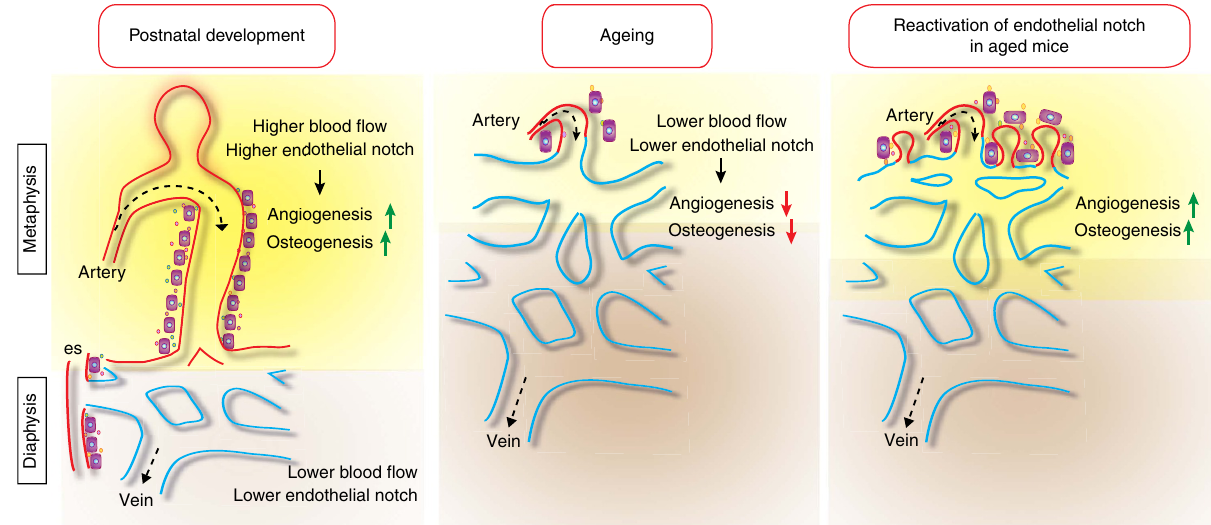
Figure 7 | Schematic representation of key findings. Postnatal angiogenesis in bone involves the formation of arch and bud structures. Blood flow is higher in metaphyseal type H vessels, which correlates with higher expression and activity of the Notch pathway. Reduction of flow impaired endothelial Notch activity, bone angiogenesis and osteogenesis. In aged mice, type H capillaries, vessel buds, endothelial Notch signalling and osteogenesis were low, all of which were reactivated by induction of EC-specific Notch activity leading to significant increases in osteoprogenitors and mineralized Bone blood flow measurements . Blood flow measurements were performed in laser Doppler perfusion imager (PIM II, Perimed, Sweden). Animals were euthanized at 16 or 48 hps and tibias were collected for analysis. tibia of mice following a previously published protocol 75 . Briefly, anaesthetized Immunohistochemistry . Freshly dissected tibiae were collected from wild type, mutant mice and their control littermates. Bone were processed and imaged as reported earlier 8,9 . The following primary antibodies were used: Emcn (sc-65495, Santa Cruz, diluted 1:100), Pecam1 conjugated to Alexa Fluor488 (FAB3628G,